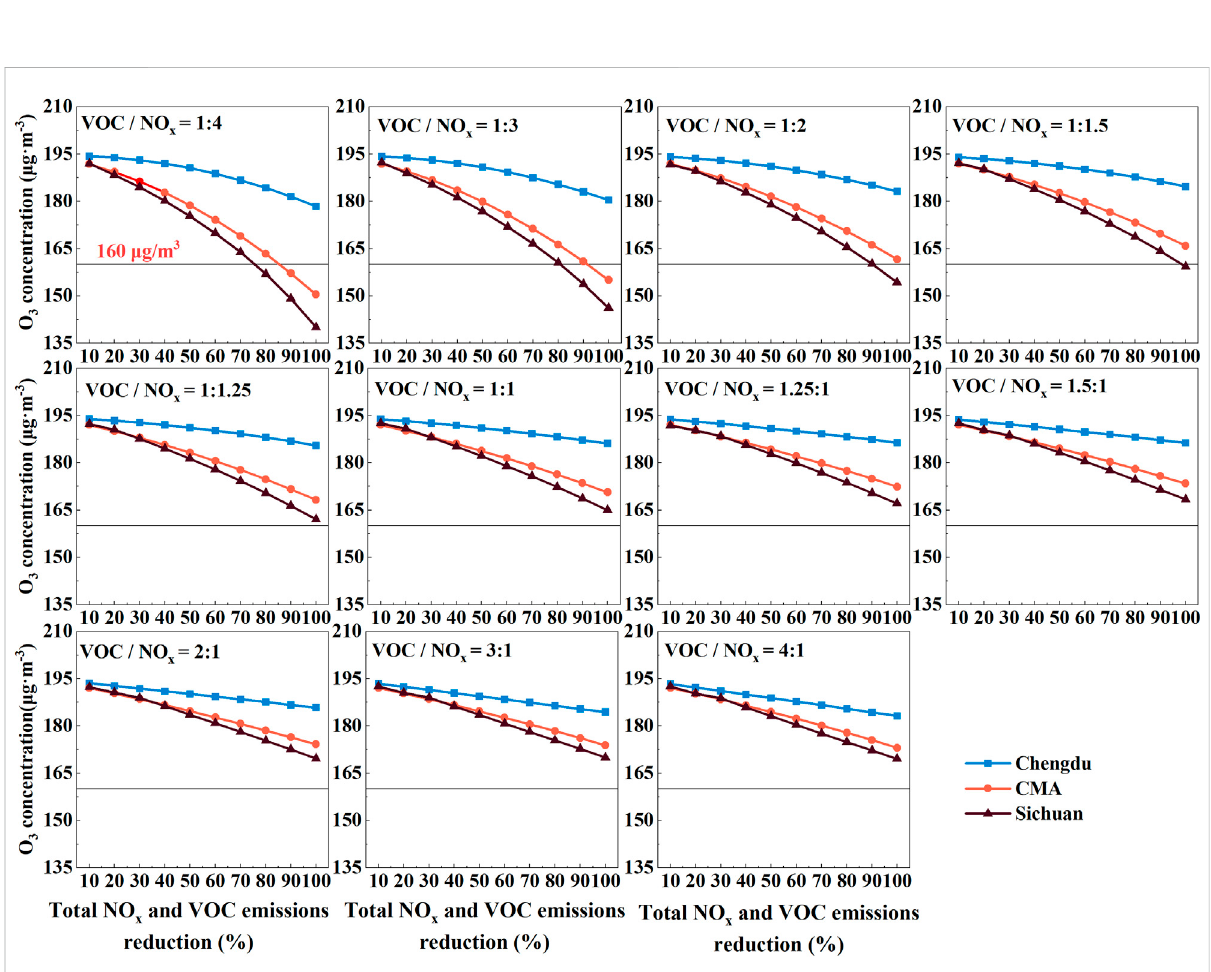
FIGURE 8 Effects of the emission reductions with different VOCs to NO x ratios on the changes in MDA8 O 3 concentrations under Chengdu, CMA and Sichuan Province scenarios.